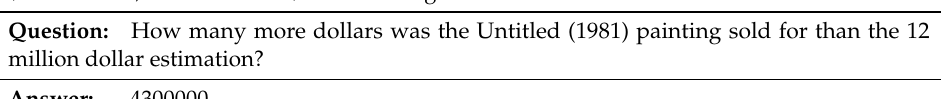
Figure 15. An example of textual free-form answer. The question-answer pair and passage are taken from the DROP [50] dataset.